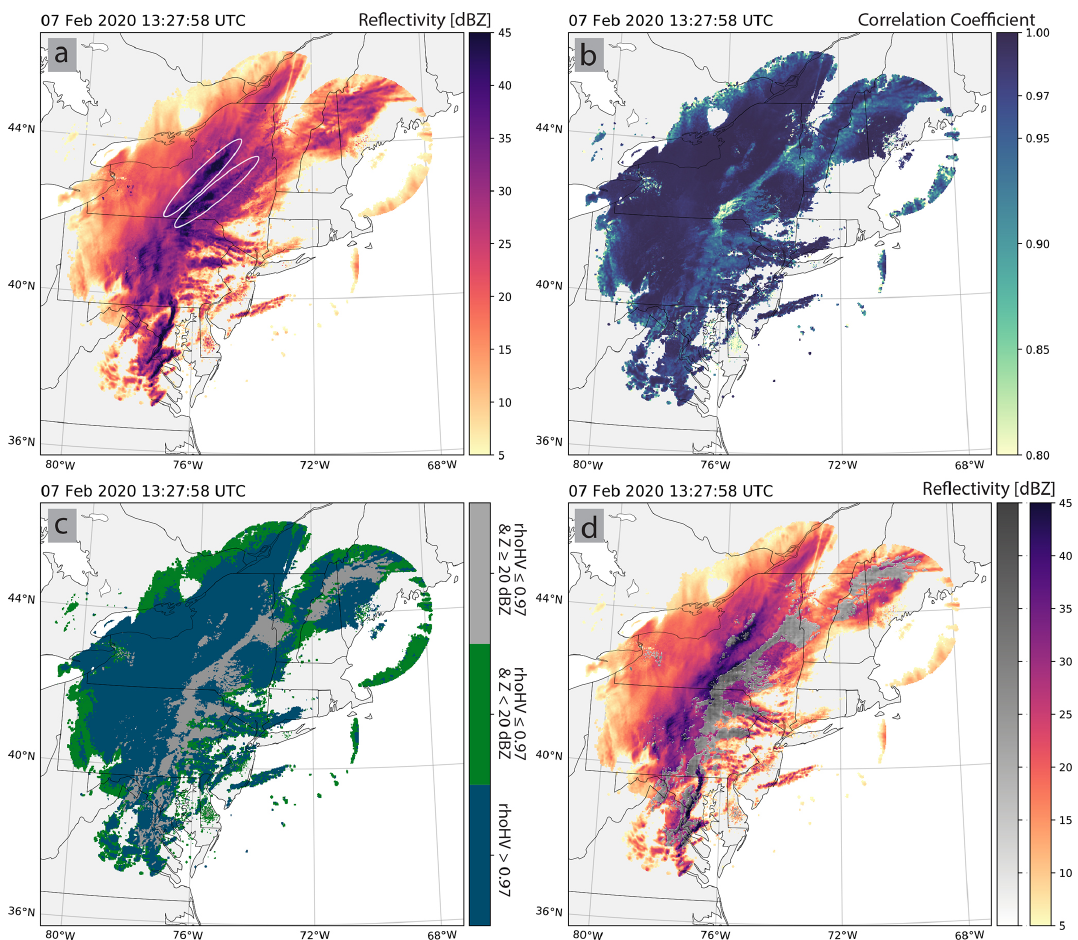
Figure 1. Image-muting processing components for a radar regional map from 7 February 2020 at 13:27:58UTC. (a) Radar reflectivity (dBZ) field. (b) Correlation coefficient field. (c) Categories indicating regions that meet the following conditions: correlation coefficient > 0 . 97 (dark blue), correlation coefficient ≤ 0 . 97 and reflectivity < 20dBZ (green), and correlation coefficient ≤ 0 . 97 and reflectivity ≥ 20dBZ (gray). (d) Final image muted product combining color scale for reflectivities in snow and rain regions with gray scale to mute reflectivities in mixed precipitation regions. White ovals in the panel (a) indicate banded features discussed in the text. An animated version (Animation-Figure-1) of this figure is in the Video